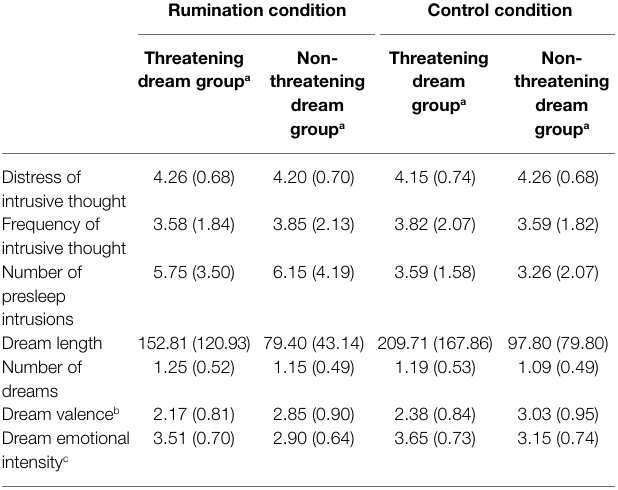
TABLE 2 | Mean (SD) participant characteristics, ratings of target thought, and ratings of dream